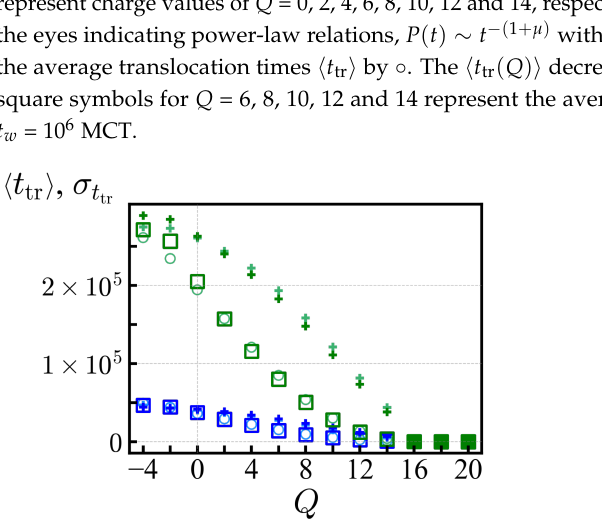
Figure 4. The average translocation times (cid:104) t tr (cid:105) in the cis -to- trans ( (cid:3) ) and reverse ( ◦ ) directions as a function of the net charge Q for N = 20. The + symbols represent the standard deviations of the corresponding data. The averages are obtained from the successful translocation trials with waiting times t w = 1.6 × 10 5 (blue) and 10 6 (green) MCTs, respectively. The filled symbols ( Q > 15) indicate the convergence of data independent of the waiting